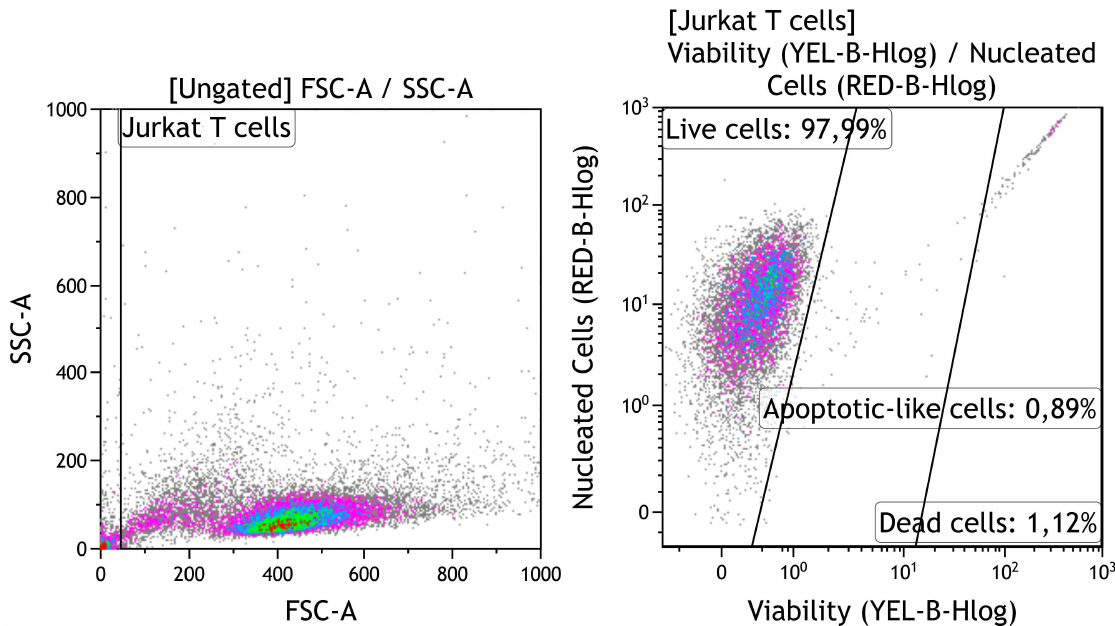
Figure 1. Strategy for gating viability of human Jurkat T cells. Cell identification based on forward scatter (FSC) vs. side scatter (SSC); Guava ViaCount